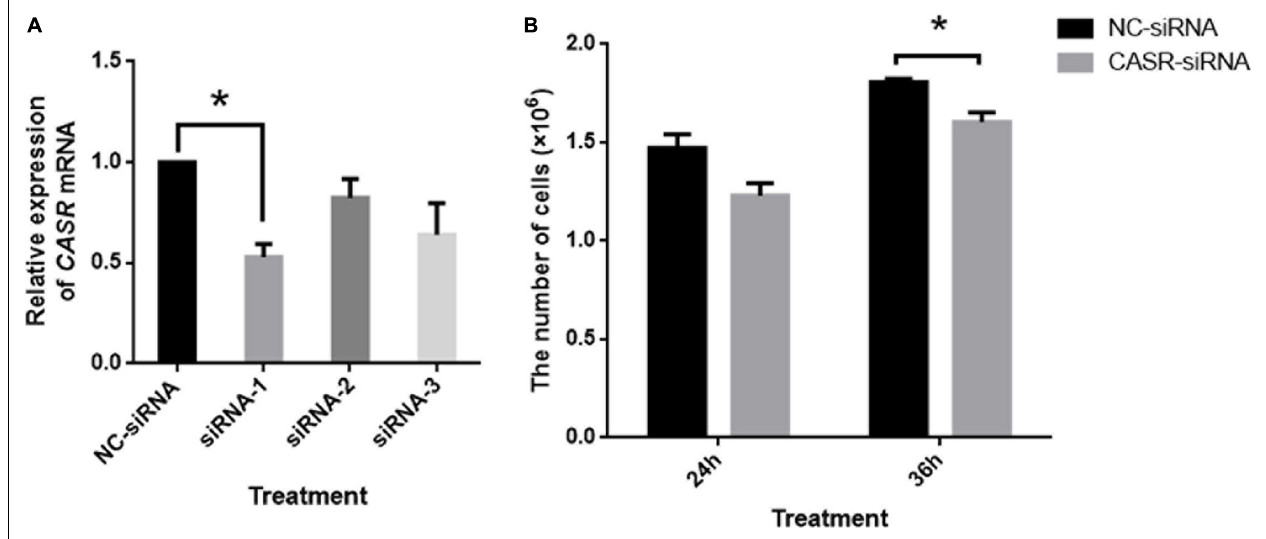
FIGURE 4 | Effects of CASR activation inhibited by siRNA on cumulus cell proliferation. Cumulus cells treated by negative control siRNA (NC-siRNA) and three kinds of small interfering RNA against CASR (CASR-siRNA) were collected. (A) The relative CASR mRNA expression levels in the CASR-siRNA- and NC-siRNA-treated groups were determined by RT-qPCR. ACTIN mRNA was used as internal control. (B) The proliferation ability of cumulus cells was tested to reflect the cumulus expansion after CASR was inhibited by siRNA for 24 h and 36 h. CASR: Calcium-Sensing Receptor. The data represent means ± SEM (* p < 0.05) from at least two independent experiments. (*) indicates significance between groups. Significance was determined by Student-Newman-Keuls (A) or two-tailed t -tests (B)